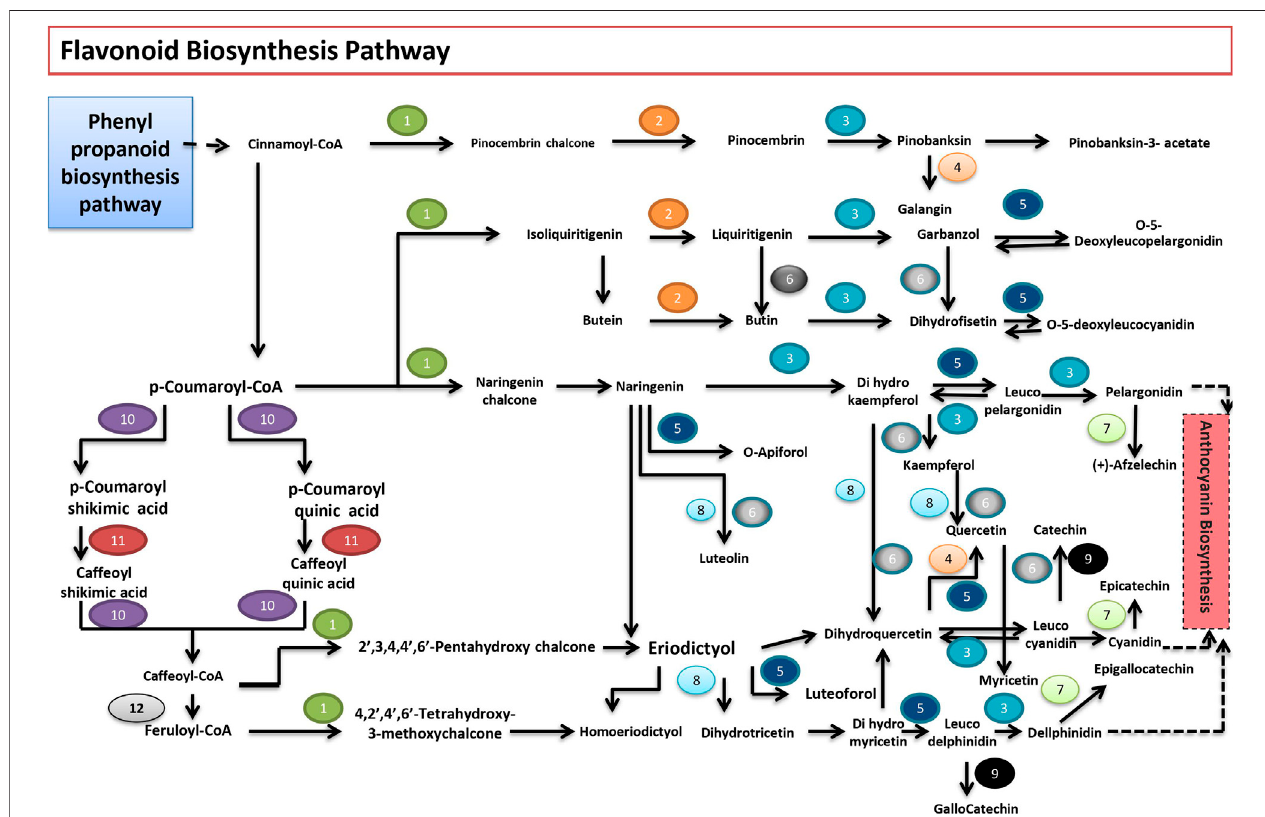
FIGURE5| Flavonoidbiosyntheticpathwayfoundin P.granatum. Numbers1to14representtheenzymesthatcatalyzetherespectivereactions.1)CHS;chalcone synthase [EC:2.3.1.74]; 2) E5.5.1.6; chalcone isomerase [EC:5.5.1.6]; 3) E1.14.11.9; naringenin 3-dioxygenase [EC:1.14.11.9]; 4) FLS; fl avonol synthase